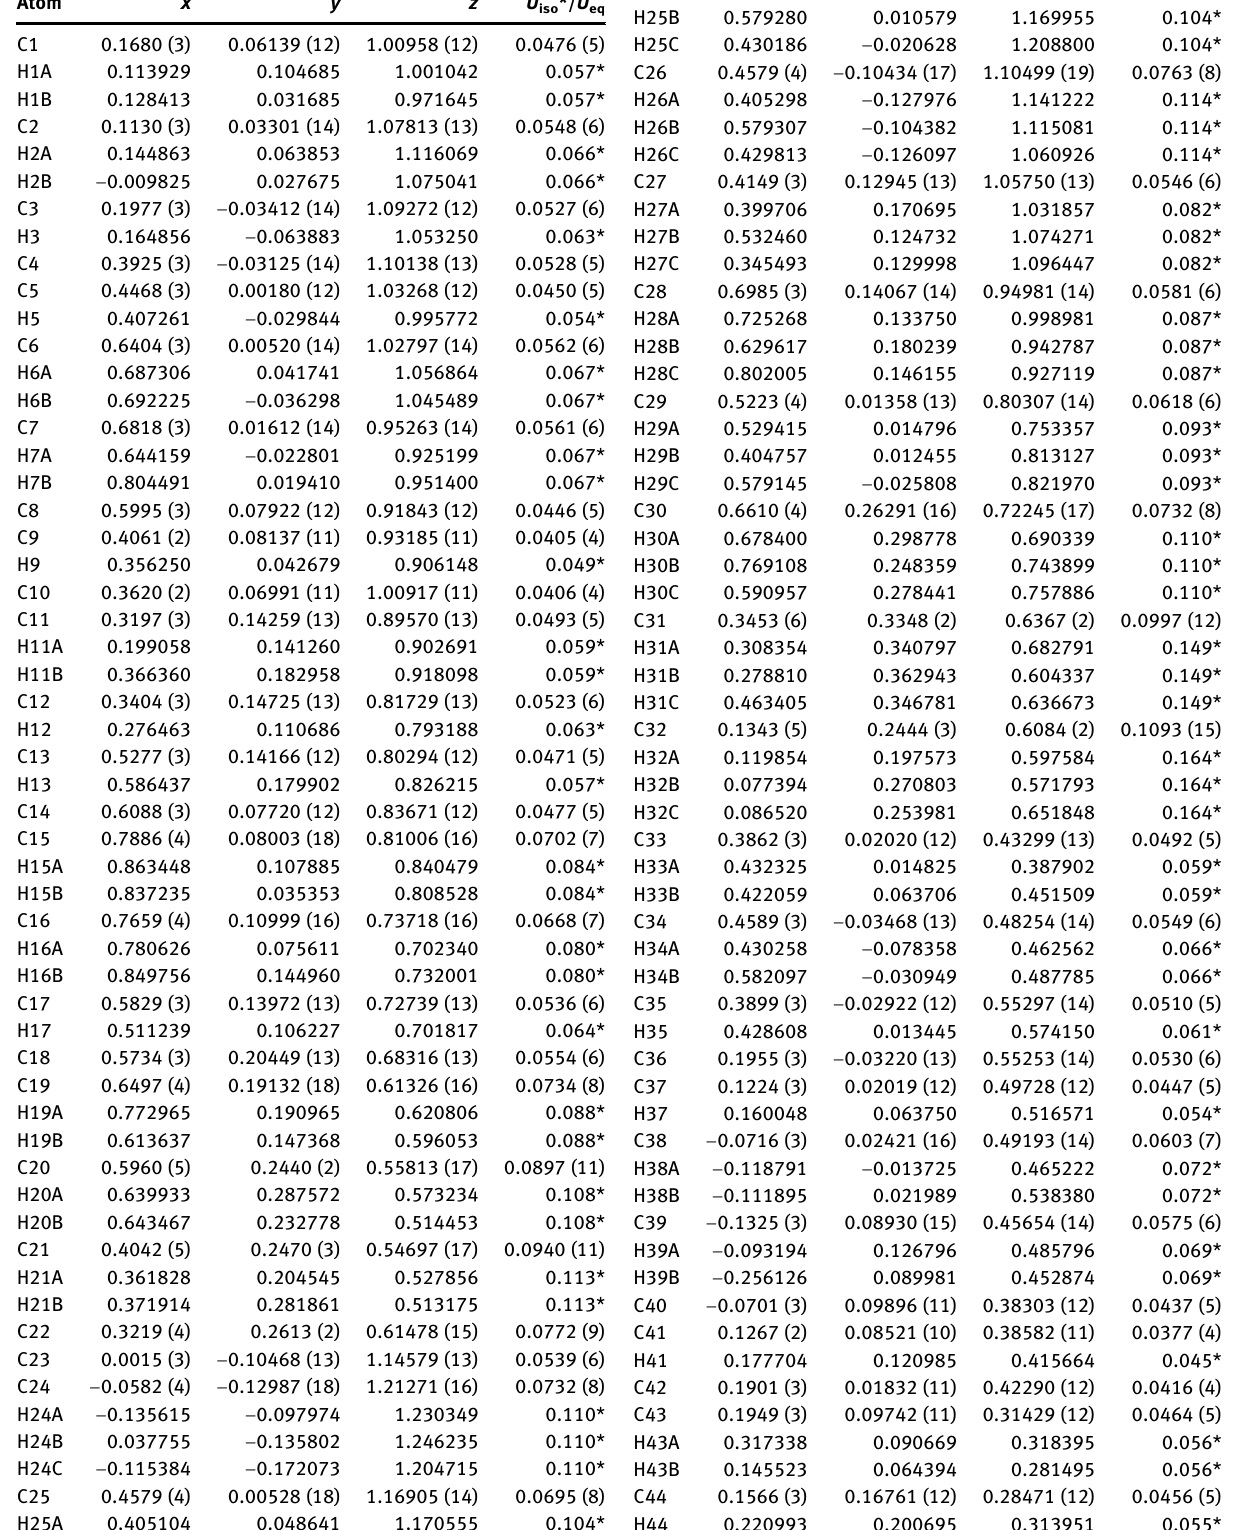
Table  : Fractional atomic coordinates and isotropic or equivalent isotropic displacement parameters (Å 